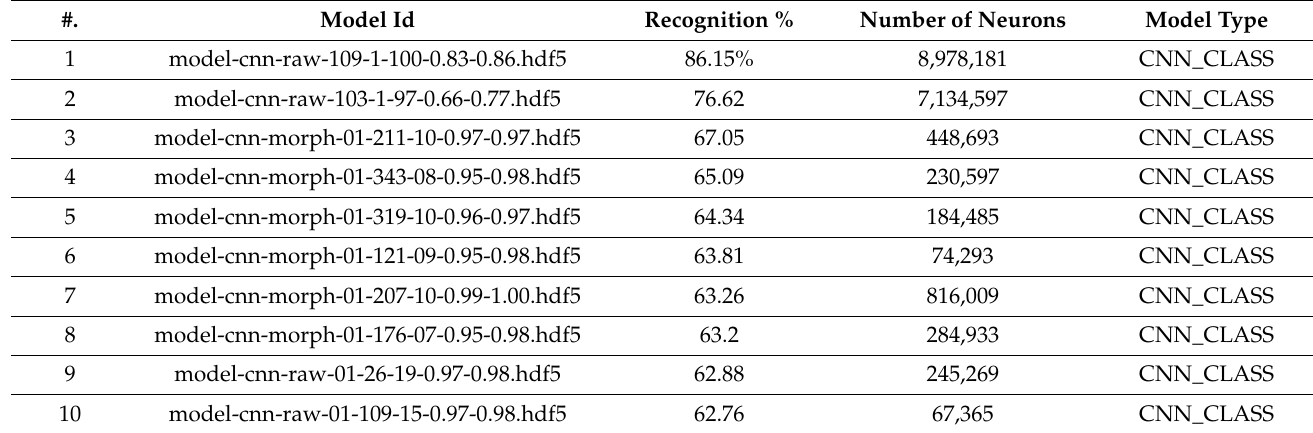
Table 1. Testing of different Neural Network models with corresponding recognition ratio.